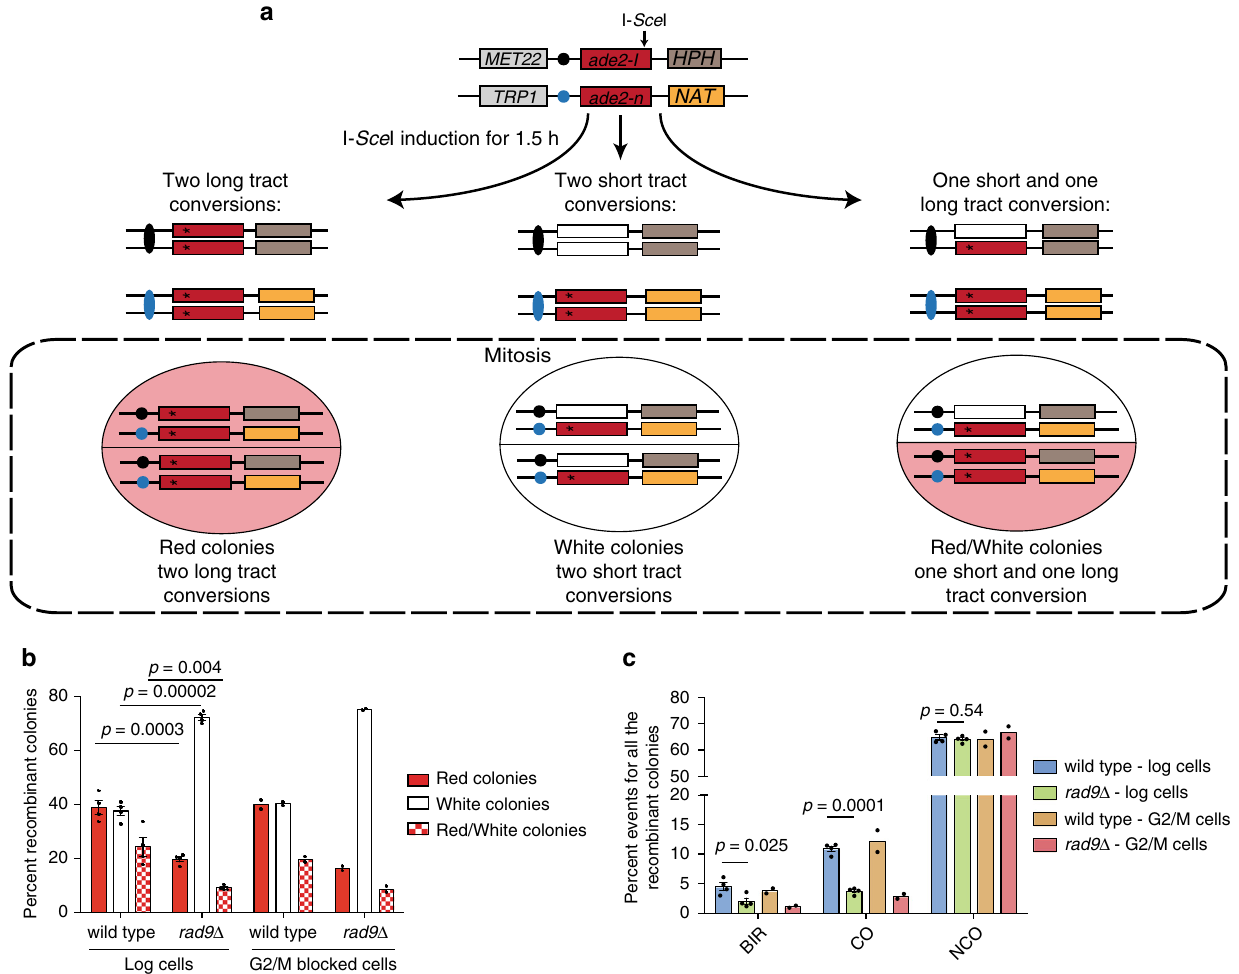
Fig. 1 Rad9 promotes long-tract GC, BIR and CO recombination. a Scheme of the genetic system to test recombination events in LSY2205-11C/LSY2543 background. See also Supplementary Fig. 1. b Distribution of the recombinant colony types in the indicated LSY2205-11C and LSY2543 derivative diploid strains. Red (two long-track conversions), white (two short-track conversions) and red/white (one long- and one short-track conversion) were determined from recombinant colonies after I- Sce I induction in asynchronous ( n = 4, genetically independent diploids) or nocodazole-arrested ( n = 2, genetically independent diploids) cells. c Percent events of CO, NCO and BIR, after normalization with plating ef fi ciency, among all the recombinant colony types of the experiments in ( b ). All the data in the fi gure are presented as mean ± SEM wherever n = 3 or more and mean where n = 2. Statistical analysis was done using unpaired two-tailed Student ’ s t -test. See supplementary Tables 1,